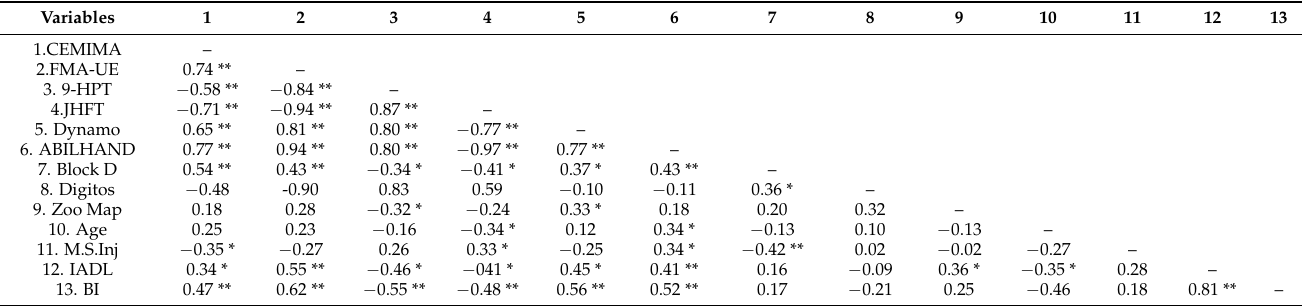
Table 2. Pearson’s correlation coefficient between MI and motor and cognitive function